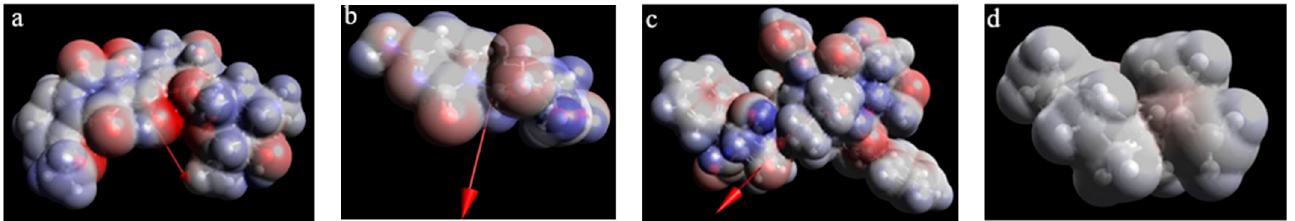
Figure 7. The electrostatic potential of the studied chemotherapeutic agents and limonene: ( a )—epirubicin; ( b )—gemcitabine; ( c )—paclitaxel; ( d )—limonene.